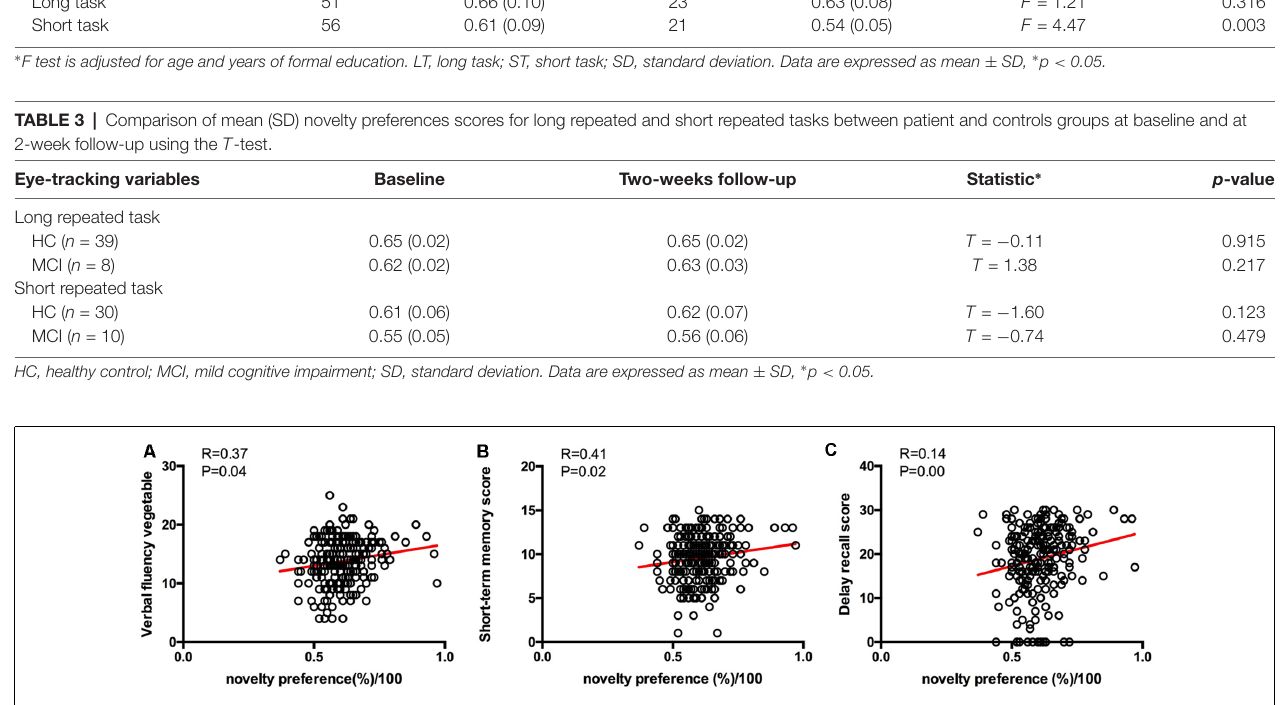
Frontiers in Aging Neuroscience |